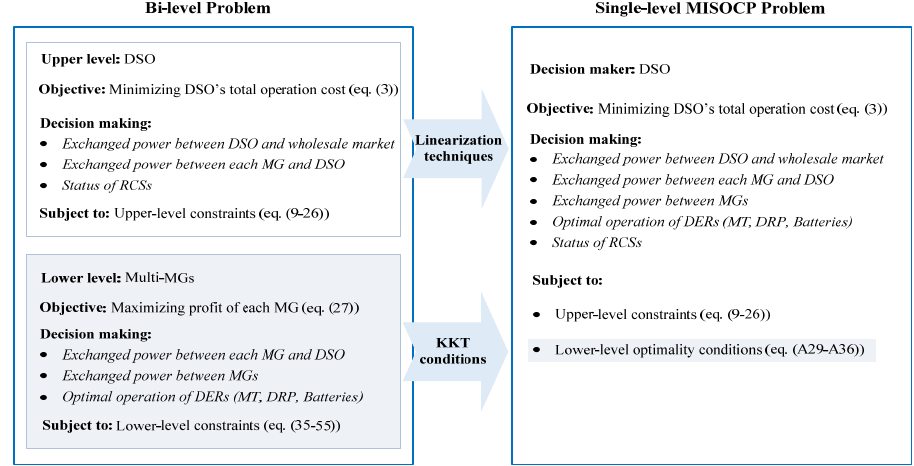
Figure 3. Problem statement and its transformation from a bi-level format into a single-level Mixed-Integer Second-Order Cone Programming (MISOCP)